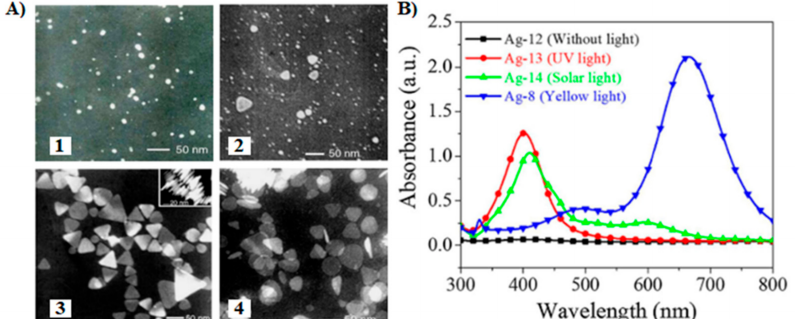
Figure 6. ( A ) Impact of the irradiation time on the shape of Ag NPs obtained from AgNO 3 , sodium citrate, and sodium borohydride irradiated with a sodium lamp (589 nm, 70 W): (1) 0 h, (2) 1 h, (3) 3.5 h, and (4) 5 h. Adapted from [168] with permission from Elsevier. ( B ) UV-Vis absorption spectra of Ag NPs synthesized under different illumination sources for 180 min. The NaBH 4 was added dropwise to the aqueous solution containing citrate and AgNO 3 ; the pH was controlled by adding NaOH. Adapted from [169] with permission from Elsevier.